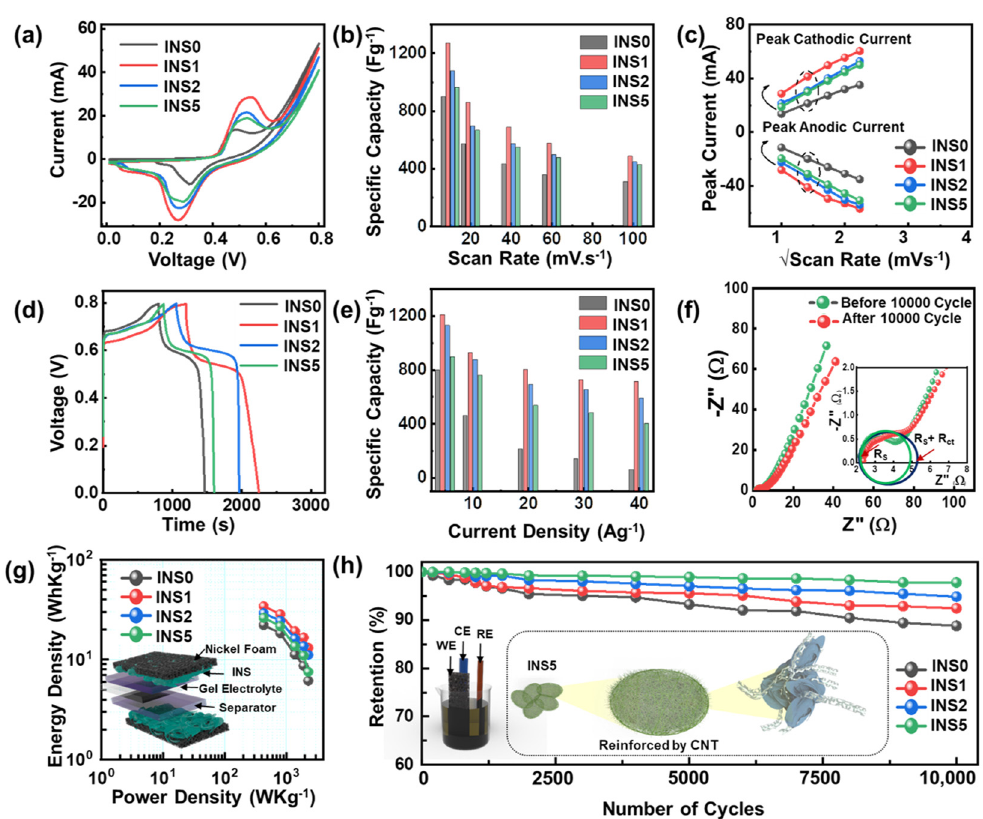
Figure 5. ( a ) Comparative CV curve of all prepared electrode samples, ( b ) calculated specific capaci- tance values at various scan rates, ( c ) comparative oxidation peak position of all prepared electrode samples, ( d ) comparative GCD curve of all prepared electrode samples, ( e ) calculated specific capaci- tance values at various scan rates, ( f ) EIS spectra of sample INS1, ( g ) Ragone plot, ( h ) cyclic retention plot (inset: scheme of conjugated INS5 for high retention) for all the prepared samples.